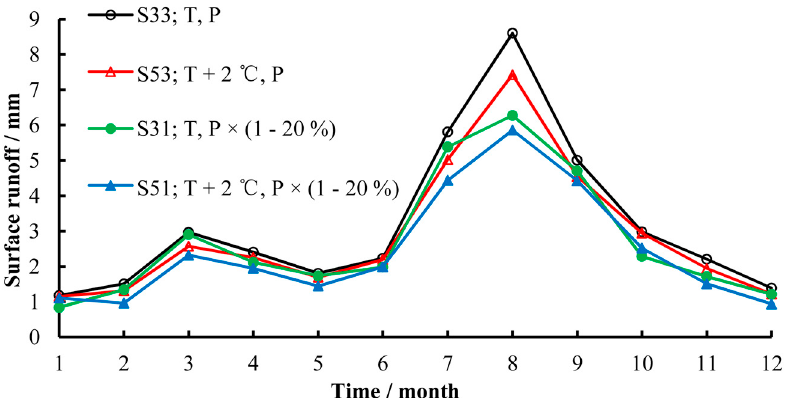
Figure 9. The distribution of monthly surface runoff of S31, S33, S51, and S53 in the Lanhe Watershed.